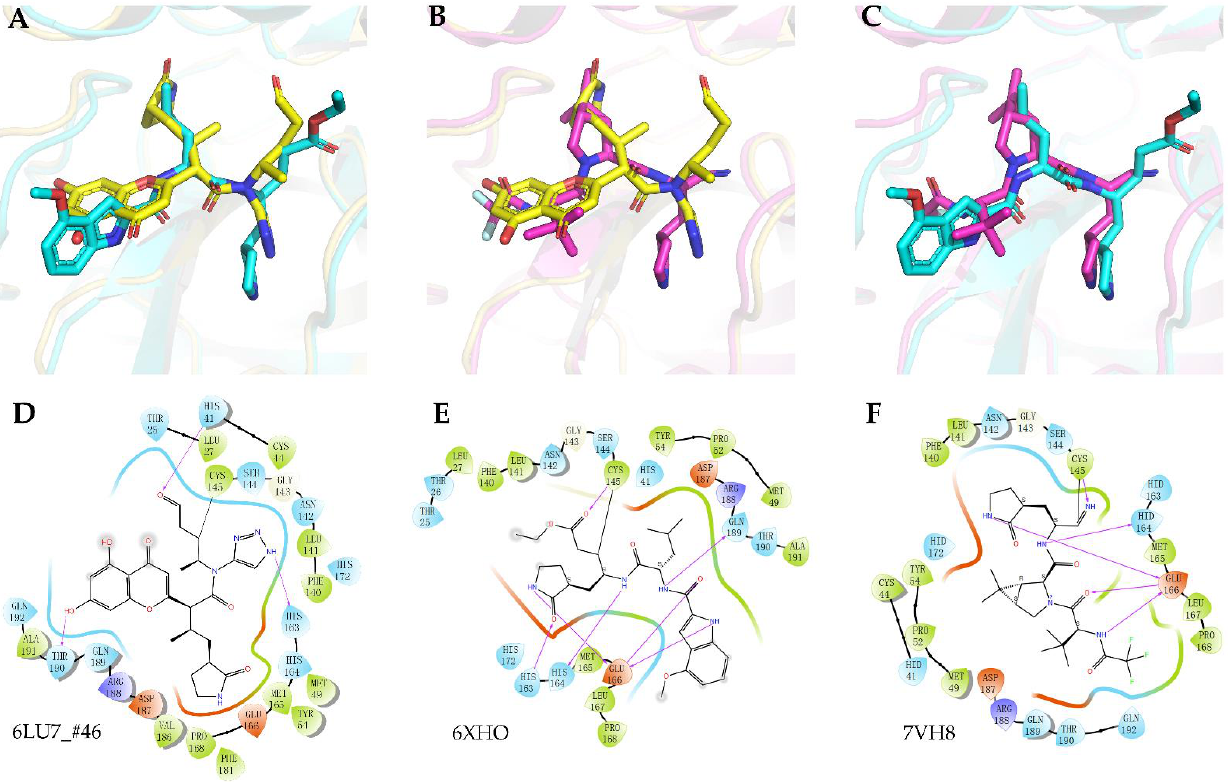
Figure 4. Co-crystal structure of the covalent adduct of ( A ) 6XHO (cyan) and ( B ) 7VH8 (magenta) bound to SARS-CoV-2 3CL pro together with the alignment of ( C ) lead compound # 46 (yellow), and the detailed interactions of the complex: ( D ) 6LU7_# 46 , ( E ) 6XHO, and ( F )